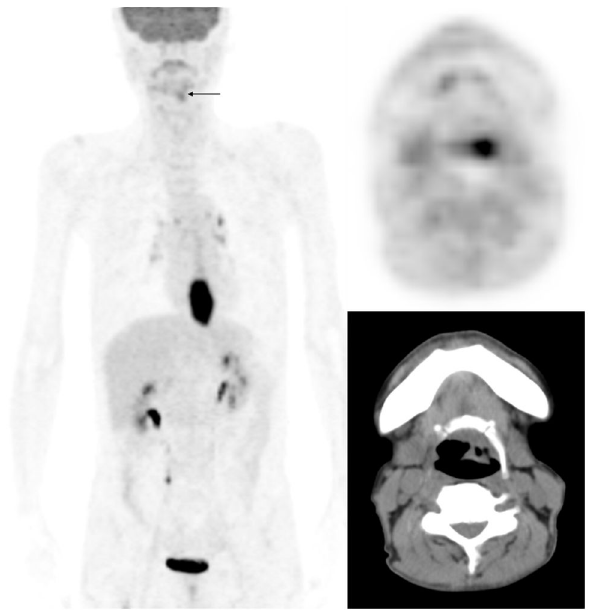
Figure 2. A case of synchronous cancer identified on FDG-PET/CT. In addition to the cancer located in the lower third of thoracic esophagus, FDG-PET/CT identified an additional left hypopharyngeal malignancy missed by conventional CT images